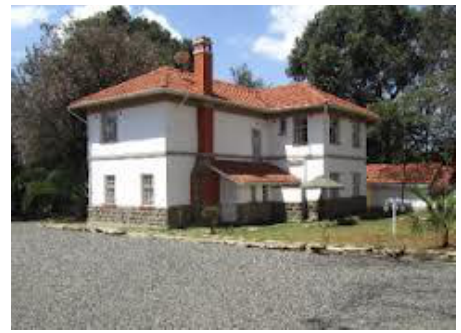
Figure 5. Typical Residential House on Sale